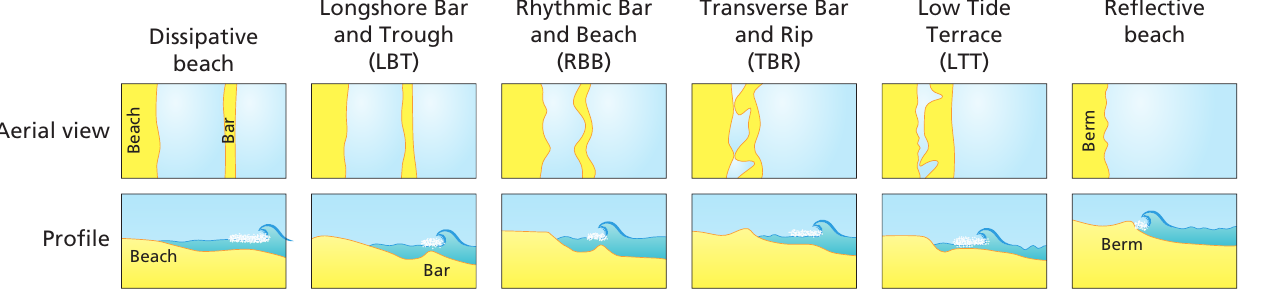
Figure 1. Schematic representation of the beach states as defined in the classification scheme of [12]. (Adapted from: